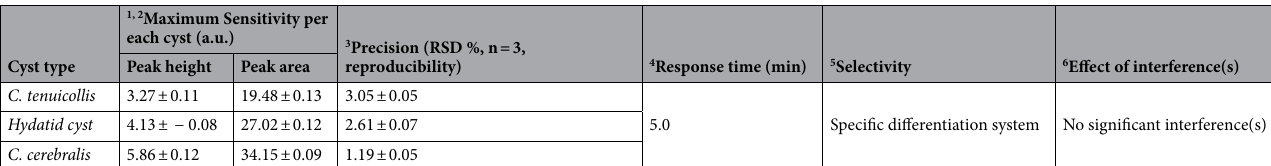
Table 4. Some figures of merit of the designed detection system. 1 Estimated based on the most intensive peak according to Fig. 6. 2 Calculated based on maximum peak height and peak area of the selected frequency peaks. 3 Percenatge of relative standard deviation. 4 Estimated based time interval needed to access to at least three sequential FIDs. 5 Estimated via comparison between the frequencies during analysis of different cysts. 6 Estimated based on comparison between the peak position of the spectra for different tested cysts. ± Relative standard deviation (n = 3), frequency step: 2